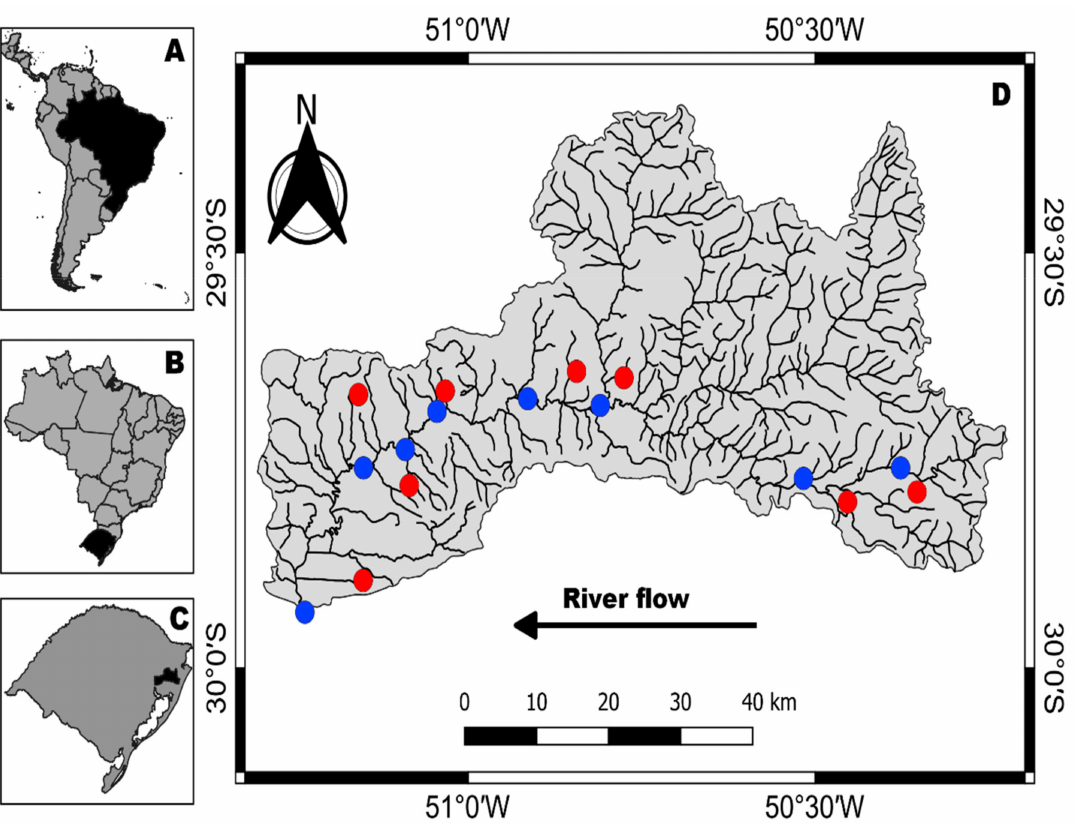
Figure 1. ( A ), South America; ( B ), Brazil; ( C ), Brazil´s southernmost state Rio Grande do Sul; ( D ), Sinos River basin. Blue dots = Raw water collection sites, red dots = drinking water collection sites in the residences. All residences were supplied with treated Sinos